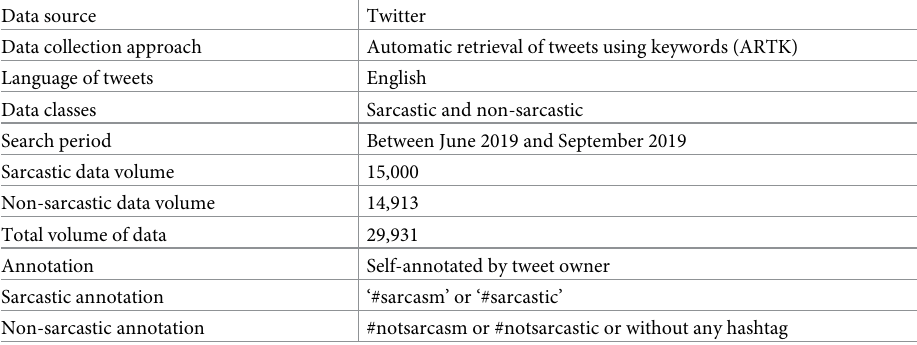
Table 3. The summary of dataset